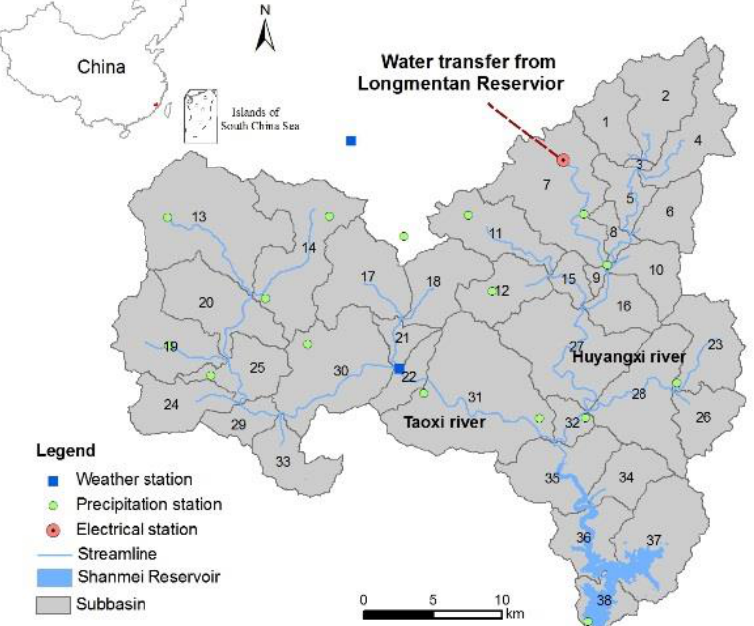
Figure 1. Shanmei Reservoir watershed stream networks.